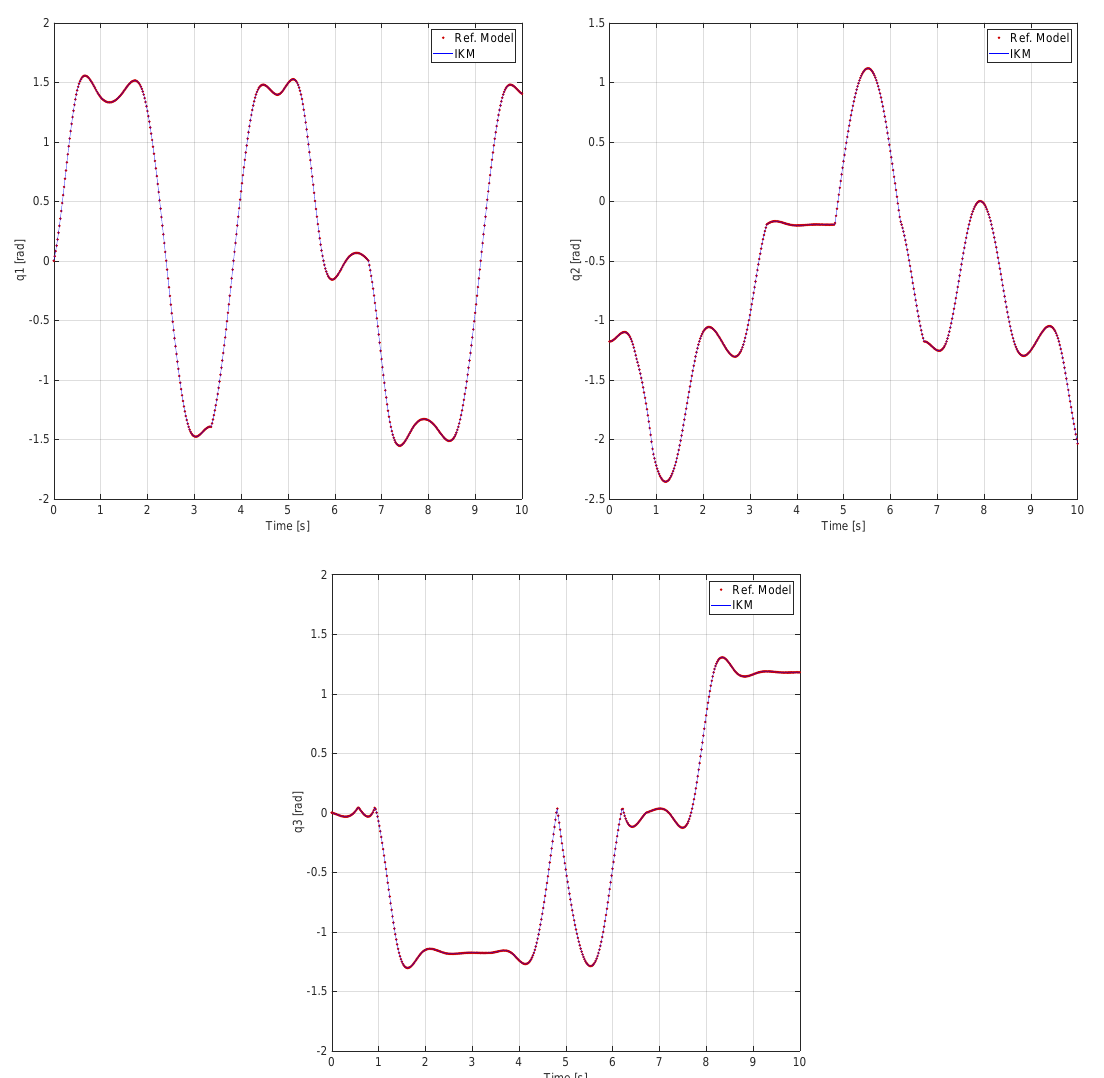
Figure 9. Trajectory tracking analysis for the PUMA’s IKM. The red dots represent the outputs of the reference model, for each of the PUMA’s DoFs, when it is supplied with the predetermined trajectory, while the continuous blue lines are the IKM’s outputs for that same trajectory. The upper left figure presents the computed outputs for the first DoF ( q 1 ), the upper right one corresponds to the second ( q 2 ), while the bottom figure are the ones for the third DoF ( q 3 ). The data show that the IKM’s outputs follow the ones of the reference model, with high accuracy and a negligible error along all the desired trajectory, in the robot’s three